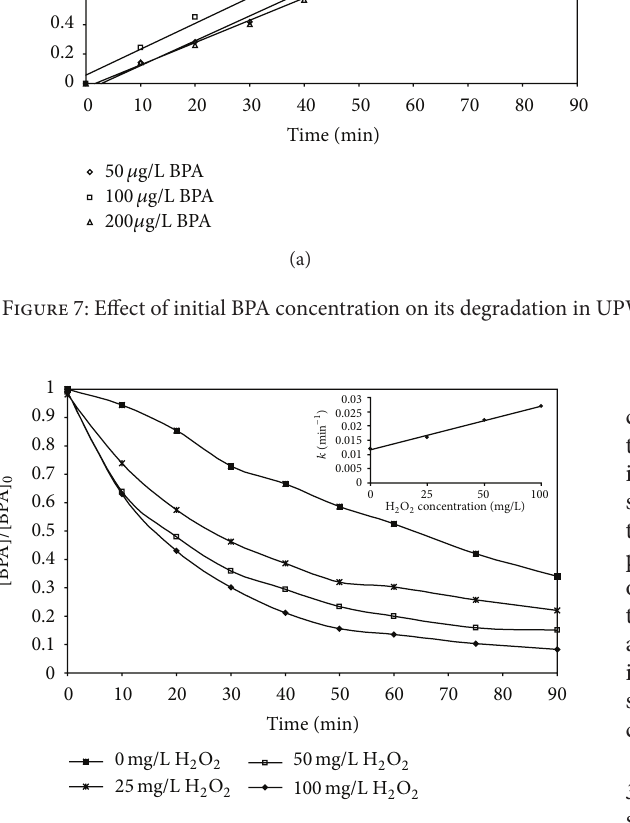
with H 2 O 2 app